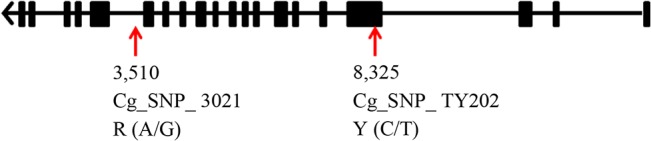
Location of the two associated SNPs in Cg_GD1.